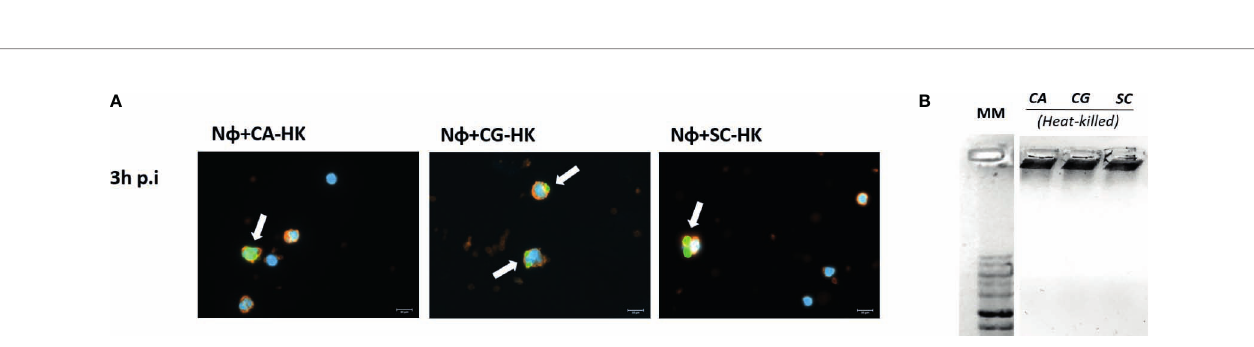
FIGURE 8 | Interaction of neutrophils with heat-killed (HK) yeast cells. (A) Neutrophils with HK- C. albicans (N ɸ +HK-CA), neutrophils with HK- C. glabrata (N ɸ +HK-CG), and neutrophils with HK- S. cerevisiae (N ɸ +HK-SC) were observed at 3 h post infection. Neutrophils ’ cell membrane sialic acids were stained with WGA, tetramethylrhodamine conjugate (red), nucleic acids stained with DAPI (blue), and each yeast cell was stained with Oregon Green (green). White arrows indicate clusters of phagocytized yeasts. Images are representative of sets of different experiments and were captured at 63× magni fi cation. Scale bars represents 10 m m. (B) CA-HK, CG-HK, and SC-HK were incubated with NETs-enriched supernatants during 3 h. Samples were run on a 1% GreenSafe agarose gel to evaluate yeasts ability to digest nucleic acids and NETs (representative image of a set of different experiments).